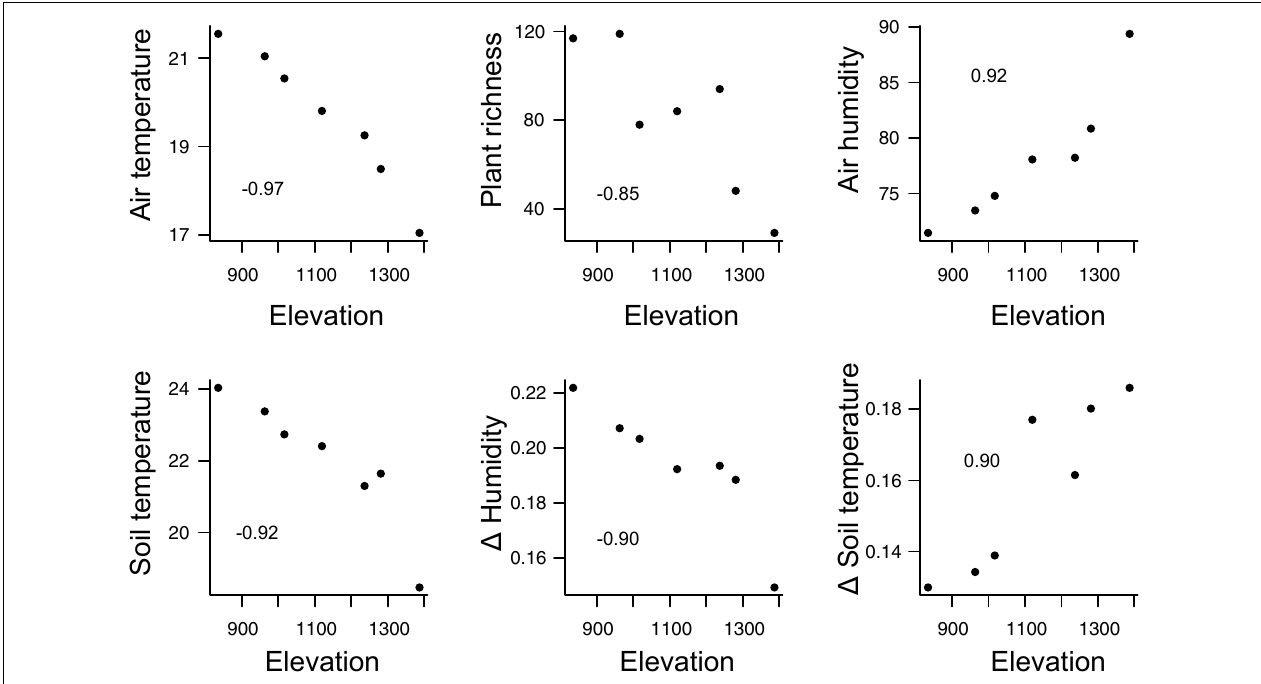
FIGURE 3 | Correlations between elevation and environmental variables. Mean air temperature, soil temperature, plant richness and the variation of air humidity decrease with elevation, while mean air humidity and the variation of soil temperature increase with elevation. All presented Pearson correlations are significant under α = 0.05. (cid:49) is coefficient of variation while the other variables represent mean values. Numbers inside the plots represent the coefficient of correlation. Data of plant richness from Mota et al. (2018). Data of climatic variables sampled using meteorological monitoring towers during 12 periods along an elevational gradient in Serra do Cipó, Minas Gerais State –